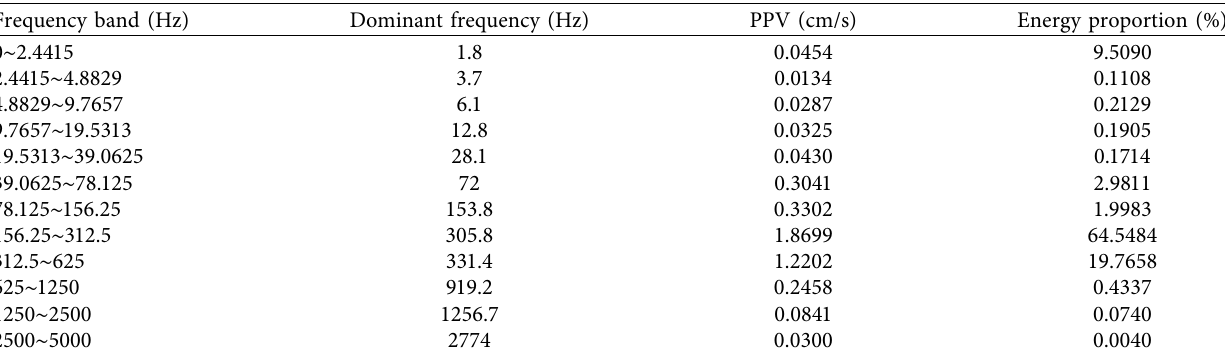
Table 4: Dominant frequency, PPV, and energy proportion of each subfrequency band at measuring point 28 in the near zone. Frequency band